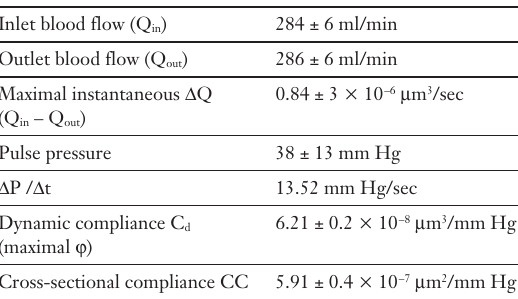
Data collected from 2 high fidelity flowmeter probes placed on carotid artery of 10 pigs, at a distance of 10 cm from each other. Q in is the blood flow in the proximal part of the considered vessel. Q out is the blood flow in the dis- tal part of the consid- ered vessel. Dynamic Compliance is ex- pressed in m m 3 / mm Hg. ϕ is the phase shift between inlet and outlet